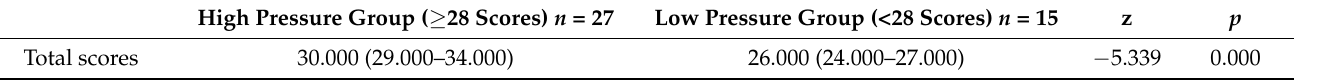
Table 3. Results of the second PSS-14 questionnaire